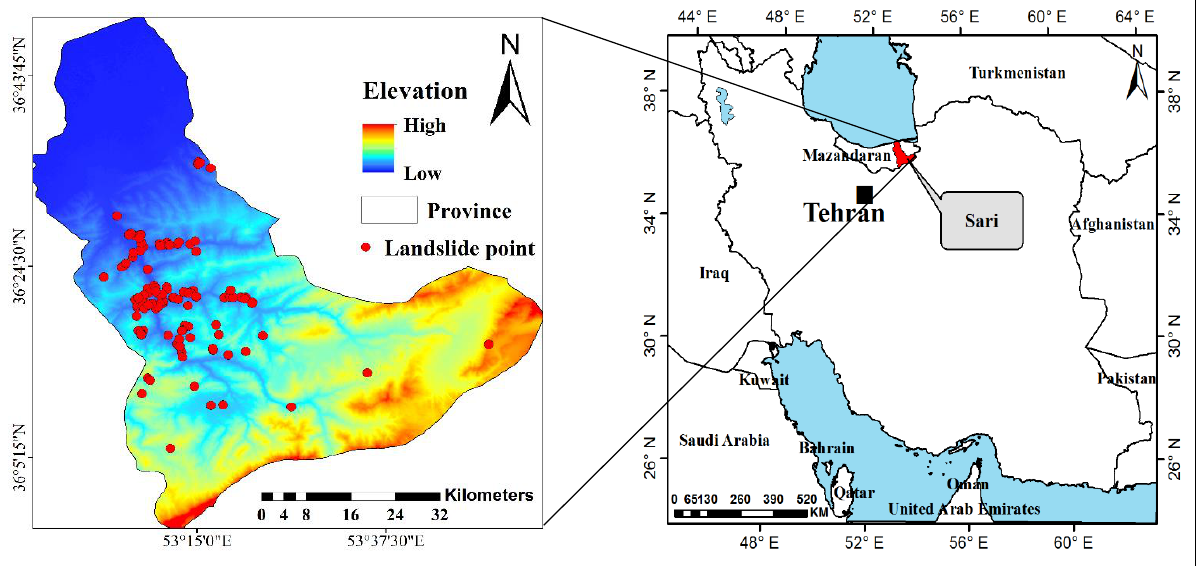
Figure 2. Location of the study area and distribution of landslide data